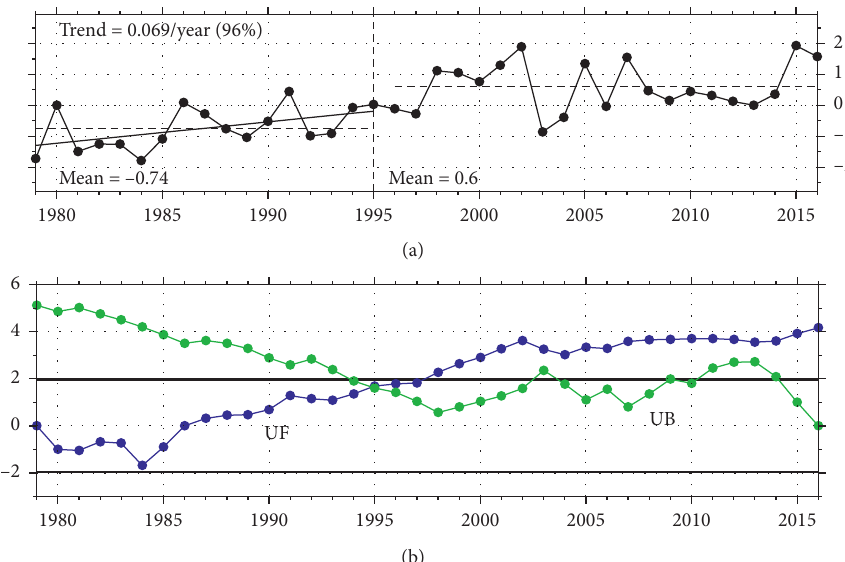
Figure 10: (a) Same as Figure 2(a) but for the summer SAT over Lake Baikal. (b) Same as Figure 2(b) but for the summer SAT over Lake